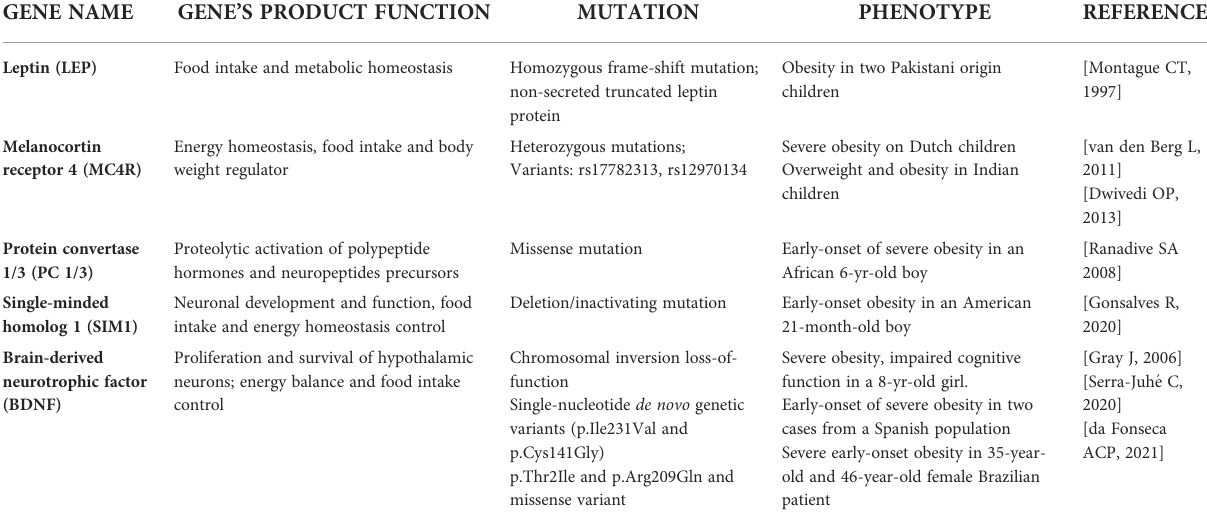
TABLE 1 Genetic determinants of monogenic obesity in